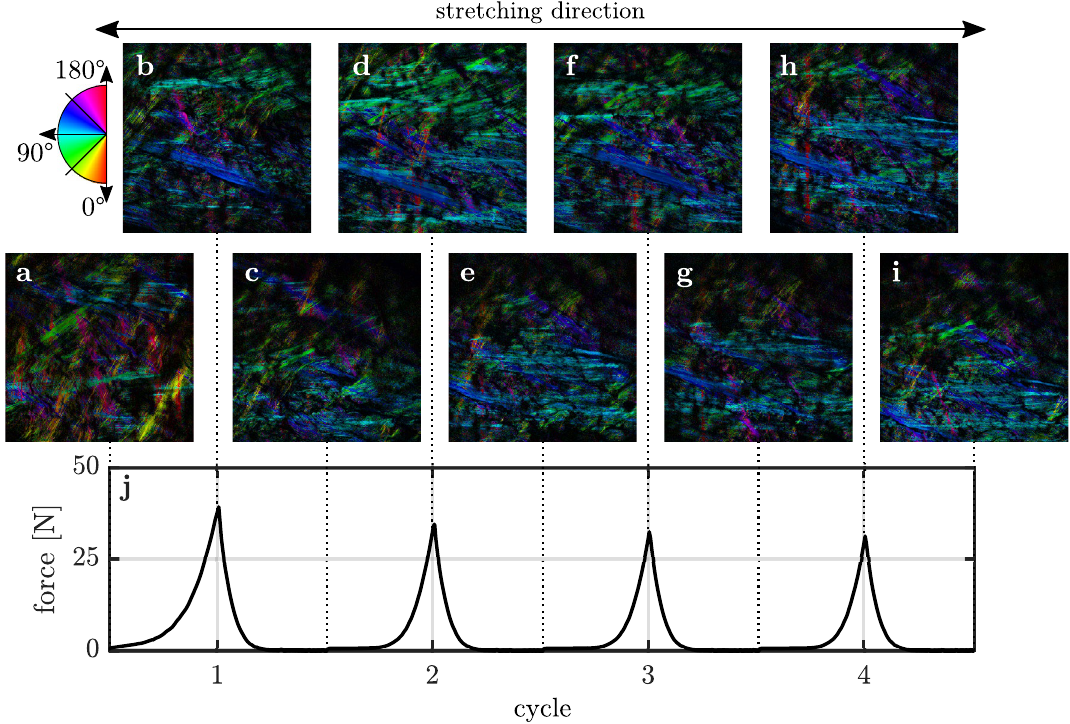
Figure 2. Evolution of the local collagen fiber orientation of the isotropic skin sample due to repeated stretching and relaxation. Local fiber orientations are shown in false colors. Dashed lines indicate the minimum and maximum strains of the corresponding stretching cycle. ( a ) Collagen fiber orientation prior to deformation. ◦ The sample is stretched in the 90 direction as indicated by the arrow. ( b ) Local fiber orientation at maximum stretch of the first deformation cycle. The corresponding local orientations at maximum stretch of the second, third, and fourth deformation cycle are shown in ( d ), ( f ) and ( h ), respectively. ( c ) Local fiber orientation at maximum relaxation of the first deformation cycle. Similarly, local orientations at minimum stretch of the second, third, and fourth deformation cycle are shown in ( e ), ( g ) and ( i ), respectively. ( j ) Averaged force acting on the sample, measured by the force sensors as a function of the deformation